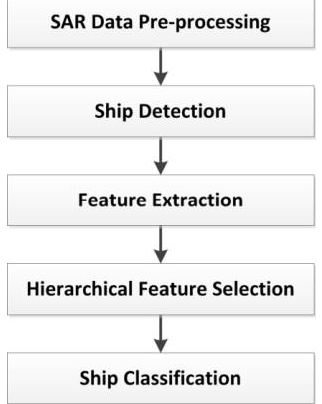
Figure 2. Flow chart of vessel